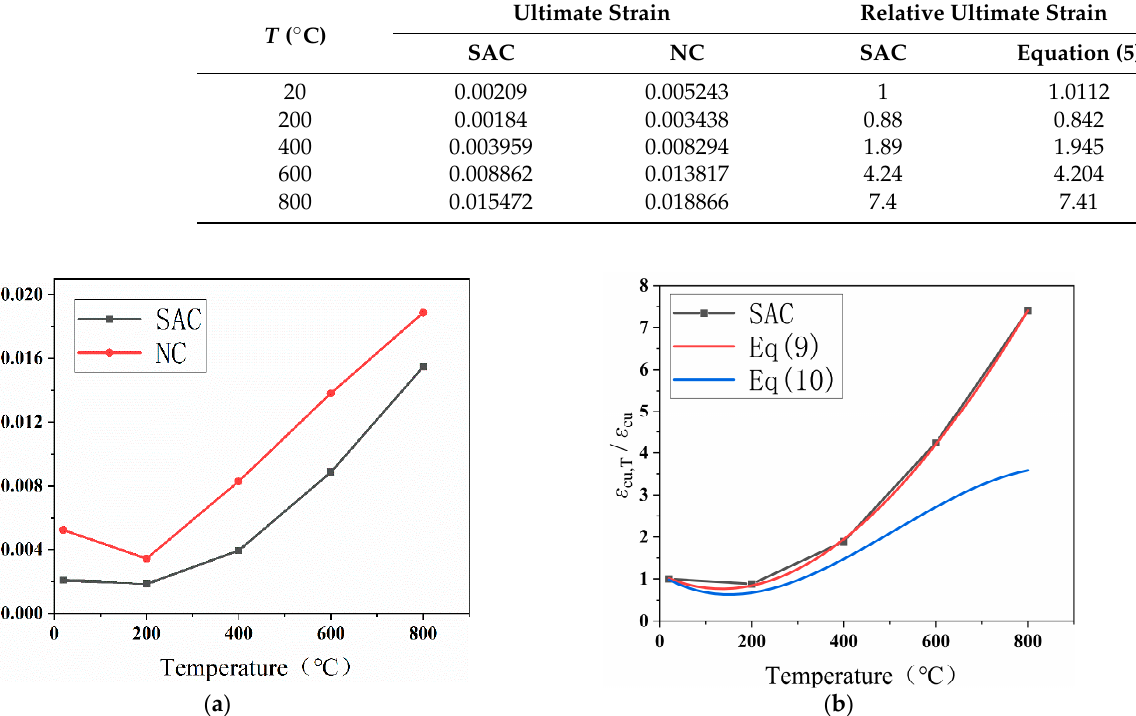
Figure 11. Ultimate strain of specimens after high temperature: ( a ) Ultimate strain. ( b ) Relative ultimate strain.